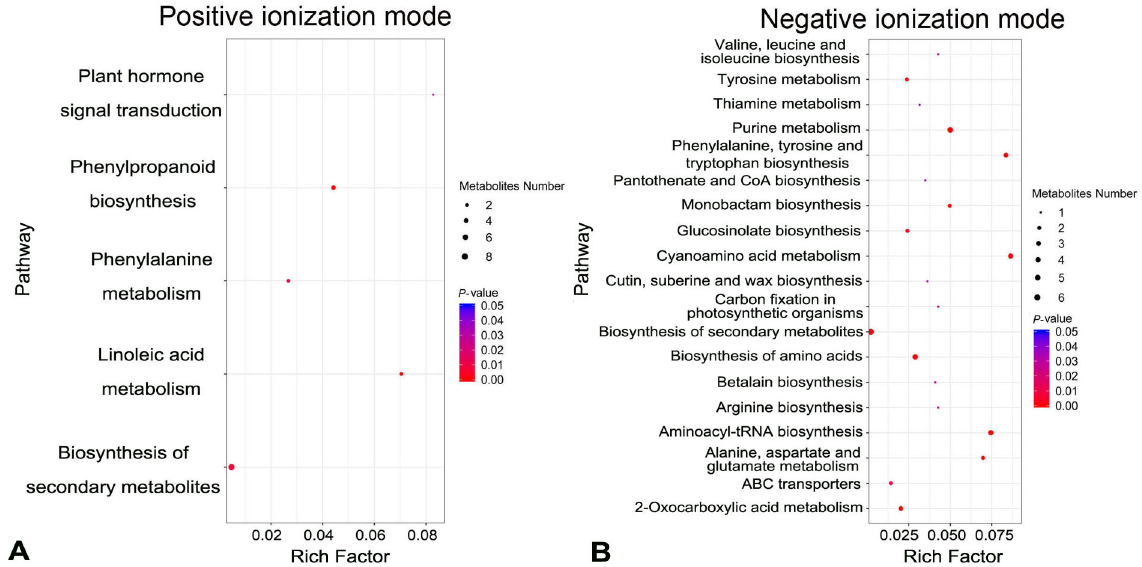
Figure 4. KEGG pathway enrichment analysis for differentially expressed metabolites in the posi- tive( A ) and negative ( B ) ionization modes, respectively.